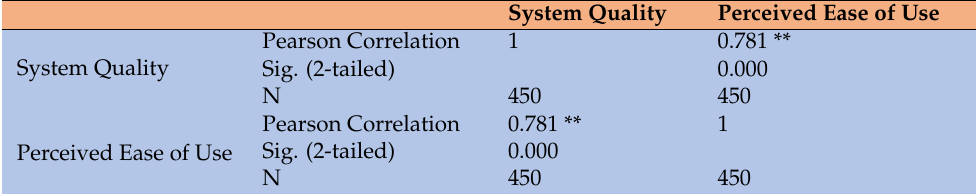
Table 6. Results of the correlation analysis for hypothesis 1 (H1).